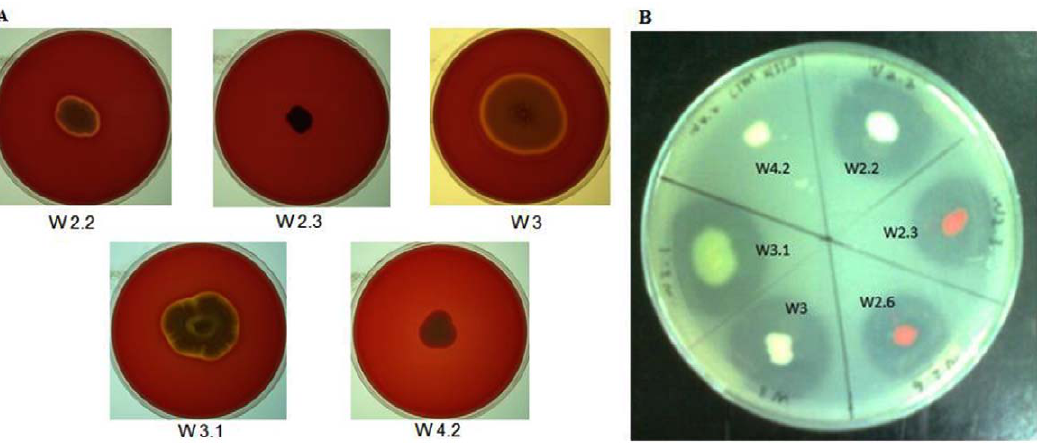
Figure 2. Extracellular enzyme activity of isolated strains. The overnight cultures of various strains were spotted on (A) 5% v/v sheep blood agar for haemolytic activity and (B) 1.5% v/v skim milk agar for proteolytic activity. A transparent halo zone around the colony was considered to indicate enzyme production. W2.6 showed high similarity with W2.3 in their 16S rDNA sequences (data not shown), hence only isolate W2.3 is selected for further analysis.